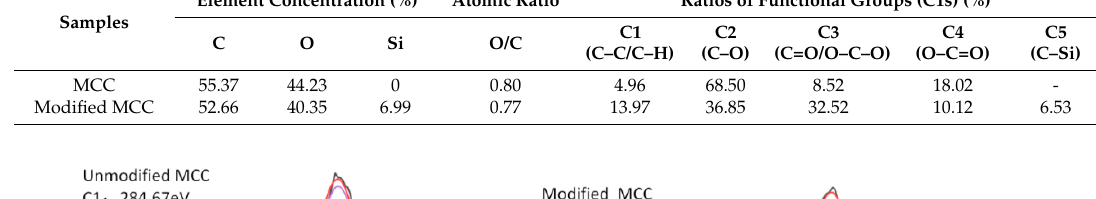
Figure 7. XPS spectra of unmodified MCC and modified MCC.